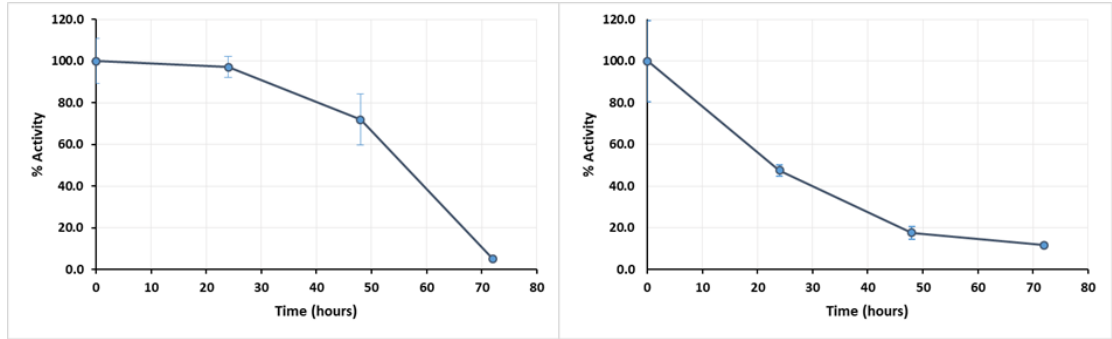
Figure 4. Curve of long-term enzymatic extract thermostability for 72 h, at pH: 4.5 and 30 °C (left panel) or 40 °C (right panel). Error bars represent standard deviation.